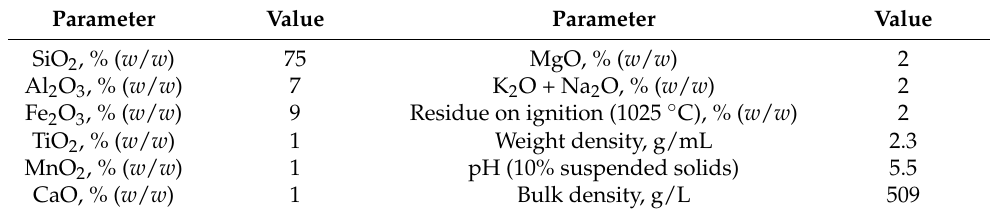
Table 1. Physicochemical properties of the tested diatomite—Absodan Plus (safety data sheet) [based on ref.